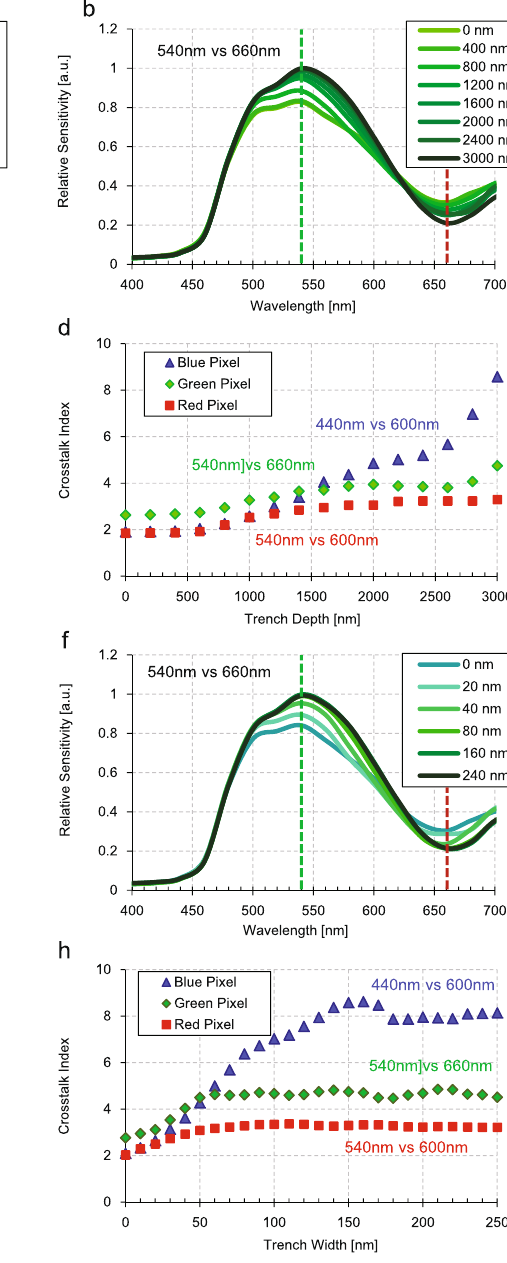
as an isotropic etchant to create c-Si (111) inverted pyramid under a carefully controlled temperature condition as KOH etching rate is sensitive to the temperature. Figure 1c,d show a cross-sectional SEM image and top-view of the inverted pyramid array with a periodicity of 400 nm and 0 nm spacing after the wet etching. The surface is passivated with a thin p + layer to minimize surface recombination and noise generation. This thin layer is also serving as anti-reflection coating. After the fabrication of the IPA structure, passivation is deposited and planar- ized over the pyramid array. Other processes are the same as the reference BI-CMOS process.